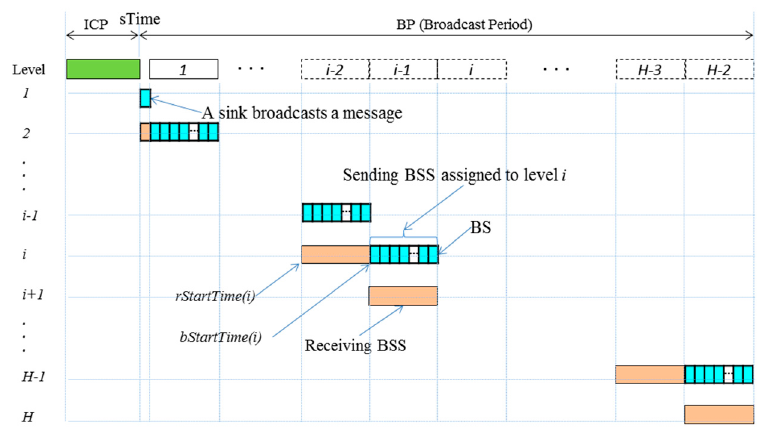
Figure 3. Protocol structure and the schedule of broadcast sharable slots (BSSs).